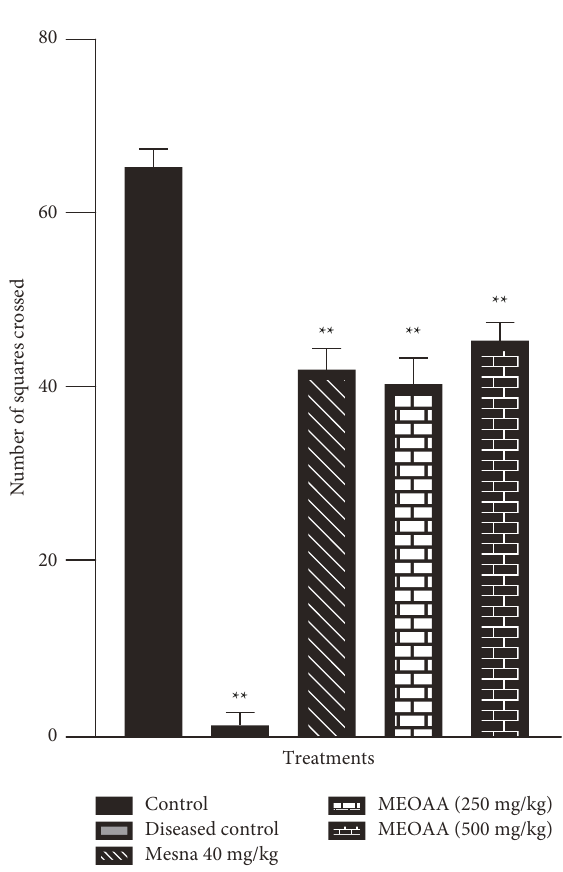
Figure 2: Data have been presented as mean ± SEM. Determina- tion of a number of squares crossed by control, diseased control (cyclophosphamide 150mg/kg), standard drug (Mesna 40mg/kg) -treated and methanolic extract of A arvensis (MEOAA) (250 mg/ kg and 500mg/kg) treated group of rats. ( ∗ P < 0 . 05 compared to the control group, ∗∗ P < 0 . 05 compared to the diseased control group; n � 4).